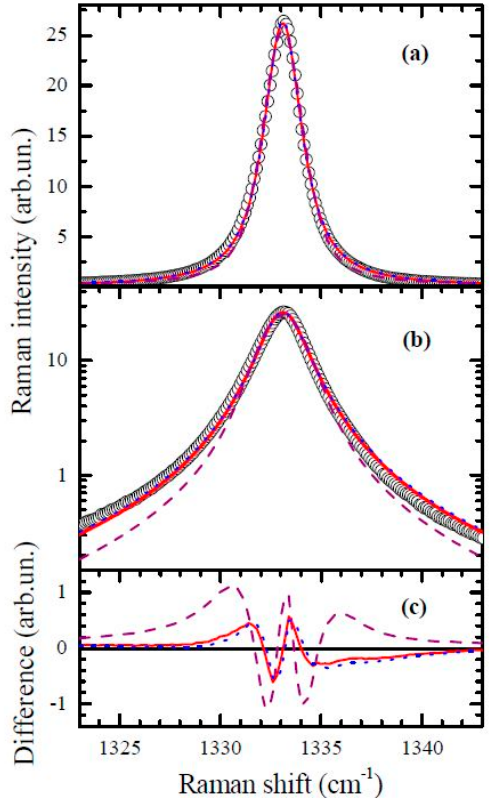
Figure 2. Raman line of the diamond with nitrogen impurities at T = 50 K (circles) and fitting curves, represented in ( a ) linear and ( b ) logarithmic scale for the intensity. The solid line is the Voight contour fit without restrictions for the fitting parameters; the dotted line is the Voight contour fit with the Gaussian width fixed to the instrumental resolution; the dashed line is the Voight contour fit with the Lorentzian width fixed to that of the Raman line of the defect-free diamond. ( c ) Differences between the experimental data and the fitting curves, employing the same designations as in ( a , b ).